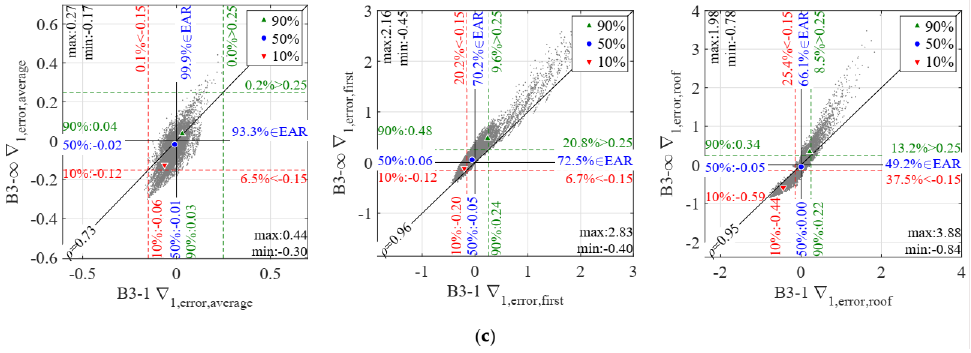
Figure 4. Scatter plots of case B3-1 versus case B3- ∞ at average of stories (left column), first story (central column) and roof (right column) for kinematic variables: ( a ) relative displacement u ; ( b ) inter-story drift ∆ ; ( c ) inter-story drift velocity ∇ .